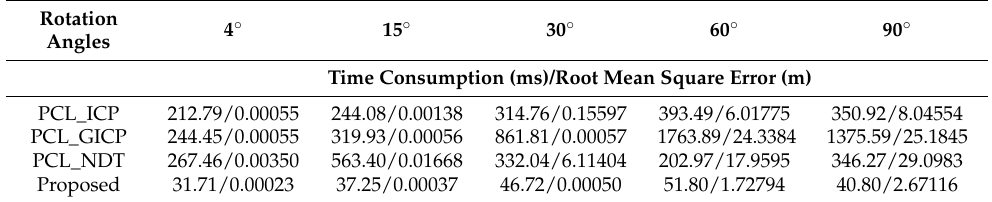
Table 2. Registration results of different algorithms for point clouds with different angles.